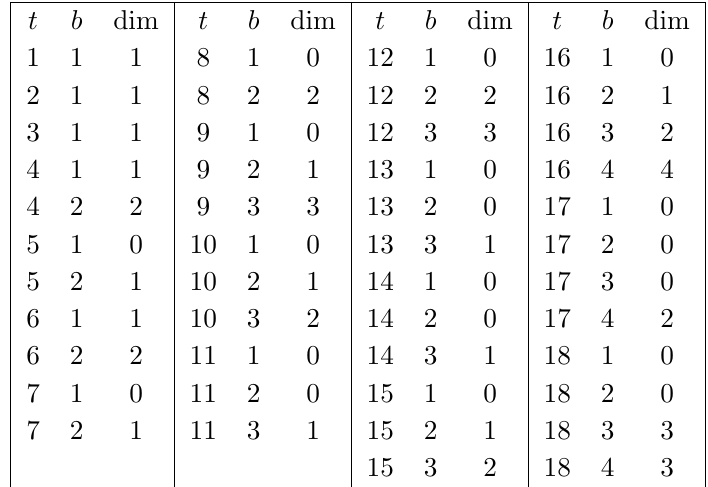
Table 2 . Dimension of space of promising forms. When the dimension is zero, it means that a wJf of index t and most polar term y (cid:0) b does not